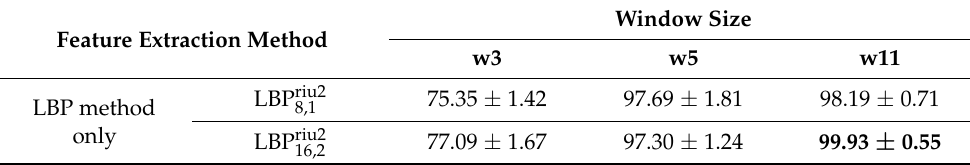
Table 2. Classification accuracy (OA) using the random sampling, for the Indian Pines dataset, with different windows size, of dimension 3 × 3, 5 × 5 and 11 × 11, for the LBP histogram